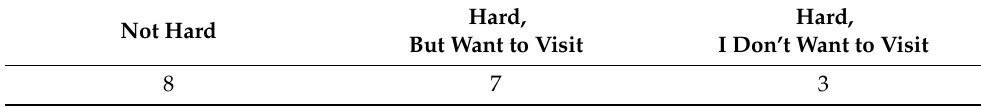
Table 7. Opinion regarding the difficulty in visiting the observation